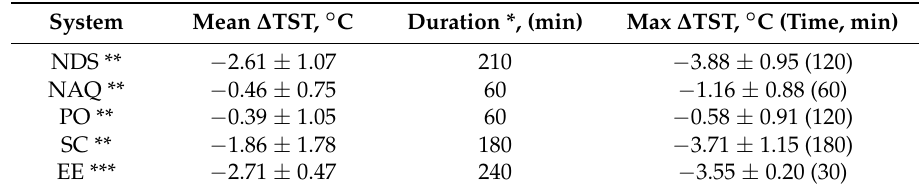
Table 2. Pharmacodynamic parameters of buspirone NDS administration to OVX rats as compared with controls ( n = 8 for each group), mean ± SD.